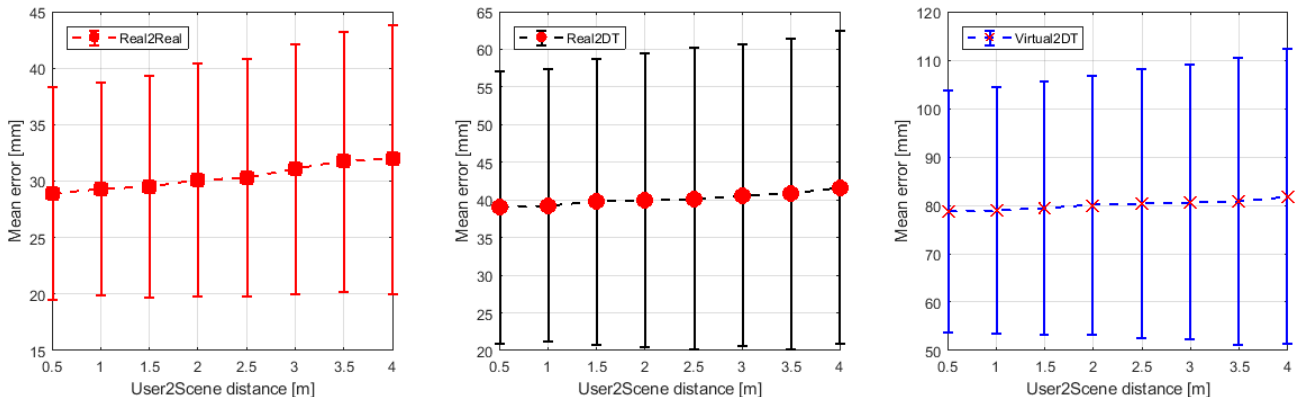
Figure 17. Mean measurement error and its standard deviation for measurements made at different distances from real and virtual